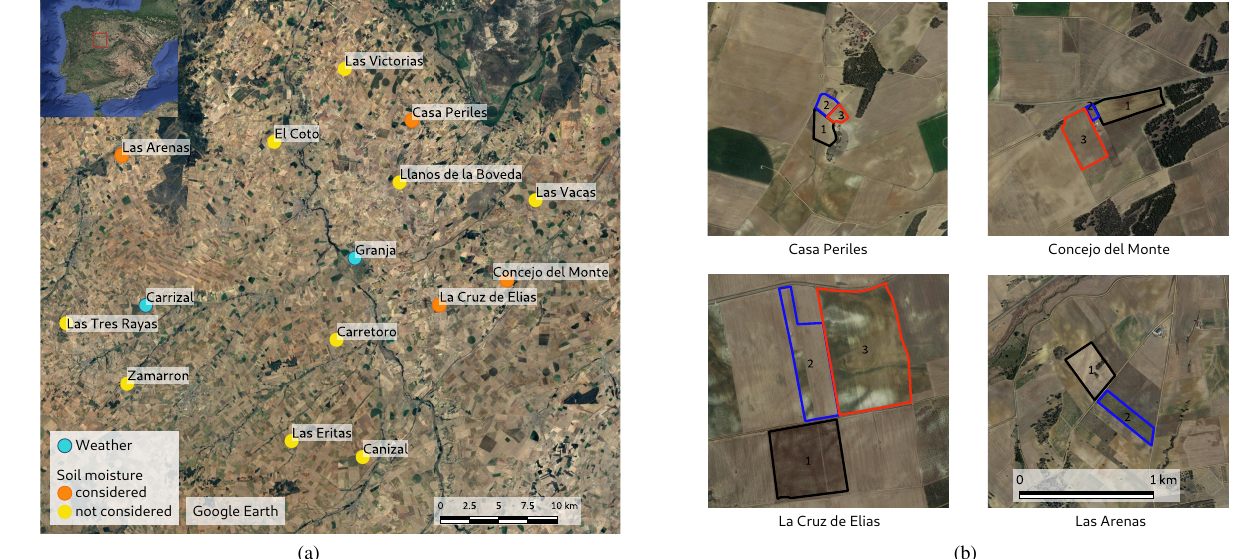
Figure 1. 1a) Location of the study area and of the soil moisture (yelow and orange dots) and weather (light blue dots) stations of the REMEDHUS network. 1b) Selected fields around the measurement stations highlighted in orange in Figure 1a (Casa Periles, Concejo del Monte, La Cruz de Elias and Las Arenas). The fields numbered as 1 present a black outline, fields 2 a blue outline, fields 3 a red outline. Background image of Google Earth under their terms of